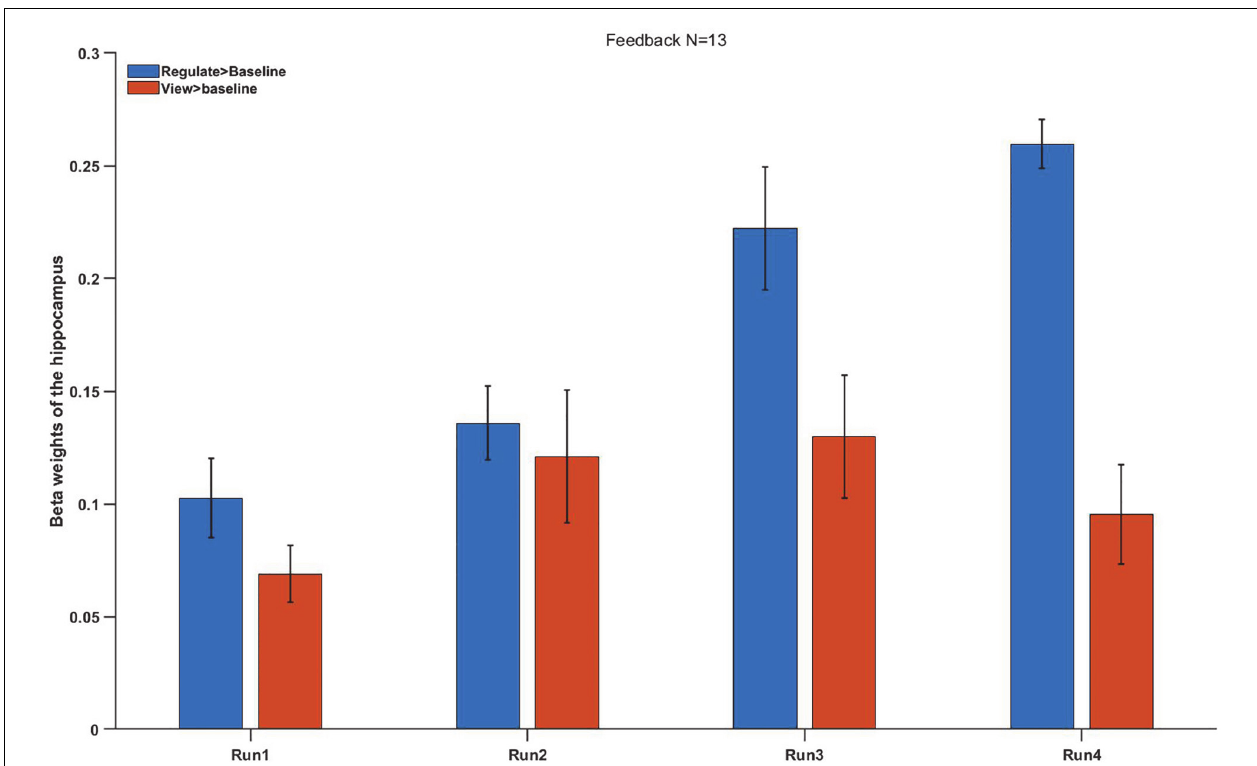
FIGURE 5 | Mean beta weights of the subjects’ individual localizer hippocampus ROIs. Conditions regulate > baseline (blue) and view > baseline (red) are presented during the four runs. Error bars represent the standard